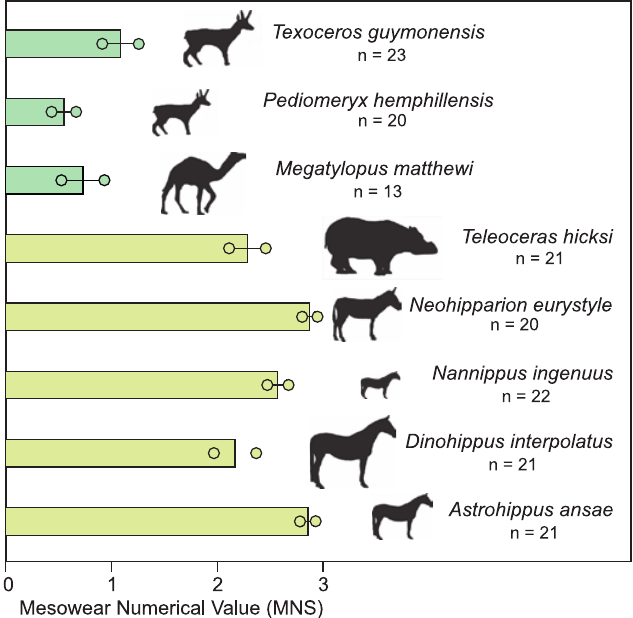
Fig. 5. Mesowear numerical values (MNS) for artiodactyls (green) and perissodactyls (yellow) from the Optima Local Fauna (Miocene, late Hemphillian, Oklahoma, USA). Color differences indicate groupings that are statistically significantly difference from one